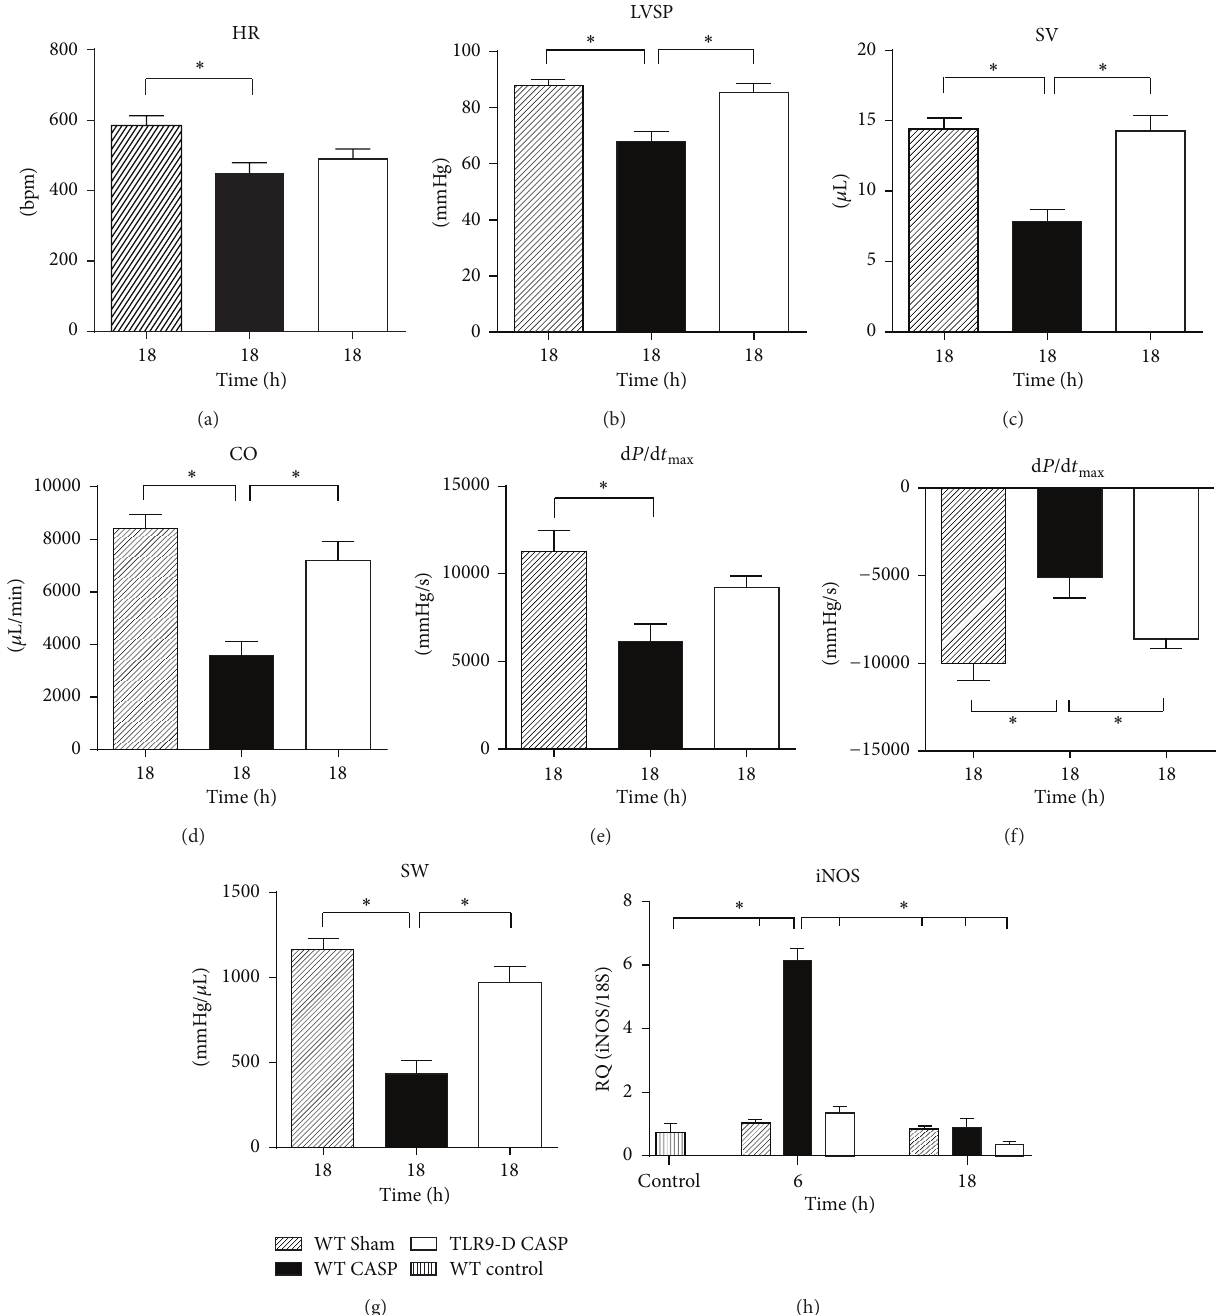
Figure 6: Left ventricular recordings of hemodynamic parameters and RT-qPCR of iNOS expression 18 hours after CASP surgery in the heart. (a)–(g) The measured parameters were (a) heart rate (HR), (b) left ventricular systolic pressure (LVSP), (c) stroke volume (SV), (d) cardiac output (CO), (e) maximal first derivative of pressure rise (d 𝑃/ d 𝑡 max ), (f) maximal first derivative of pressure fall (d 𝑃/ d 𝑡 min ), and (g) stroke work (SW). (h) Time course of iNOS mRNA expression in the heart in WT and TLR9-D mice 6 and 18h after CASP. ( ∗ : 𝑃 < 0.05 𝑛 = 8 /group; mean ±